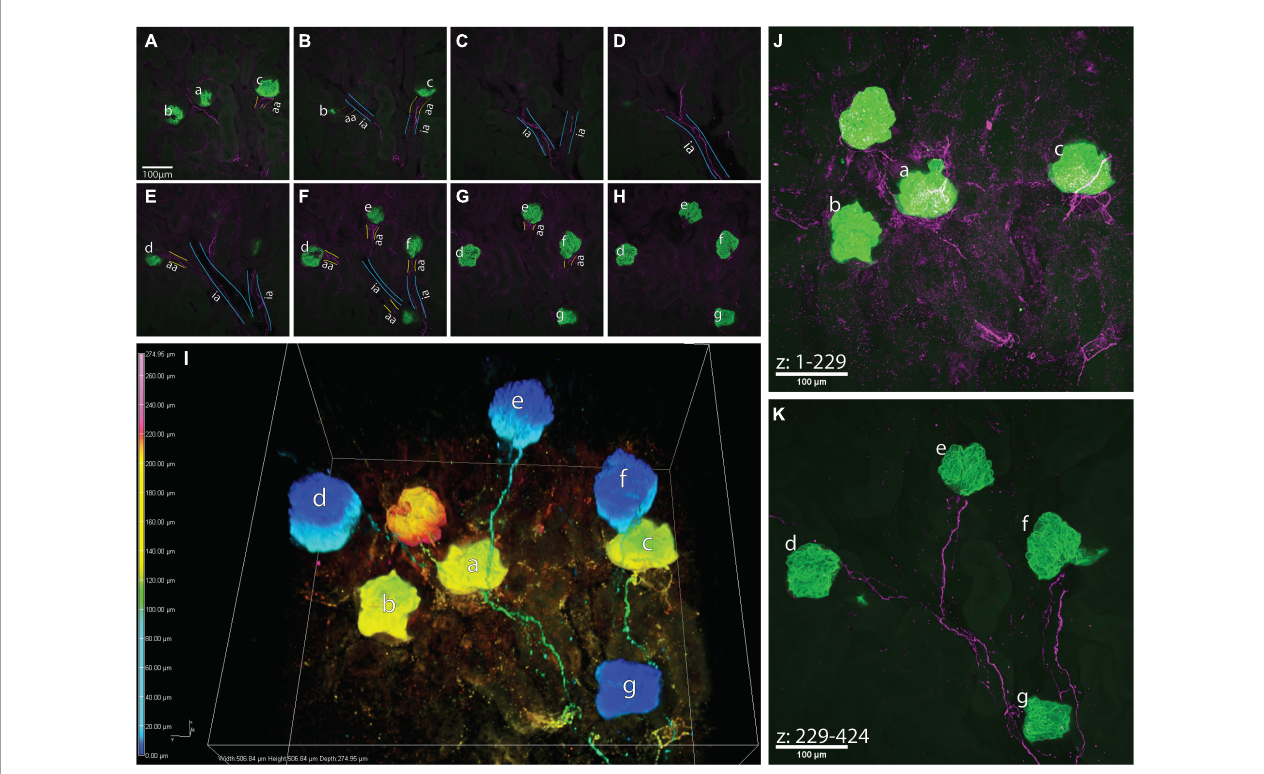
FIGURE4 A high-resolution image of calcitonin gene related peptide (CGRP)+ bundles approaching multiple glomeruli. (A–H) Maximum z-projections of 25 optical sections, collected 0.65 µ m apart, total subvolumes of 16.25 µ m each illustrating common interlobular arteries (ia, outlined in blue) branching into subsequent afferent arterioles (aa, outlined in yellow) before supplying glomeruli (a–g, green, nephrin+). CGRP+ bundles (purple) follow the branching of the common interlobular arteries and extend to glomeruli a–g as a module. It appears that glomerulus f originates from another interlobular artery, which may share a common origin with the interlobular artery giving rise to glomeruli a–e and g. (I) 3-Dimensional representation of connectivity of glomeruli by CGRP+ bundles. Color-coded by depth within the image (warm tones: deep in image, cool tones: shallow in image), nephrin-labeled glomeruli (globular structures) appear “connected” via CGRP-labeled axons, which largely travel along shared interlobular arteries en route to glomeruli. (J,K) Maximum intensity projections of z-stacks splitting the depth of the image into two sub-volumes [ (J) 148 µ m, (K) 127 µ m]. Glomeruli represented as warm tones in panel (I) (a–c) are captured within the first 229 optical sections of the image, and glomeruli represented as cool tones in panel (I) (d–g) are present in optical sections numbering 229–424. Scale bars: (A–H,J,K) , 100 µ m.